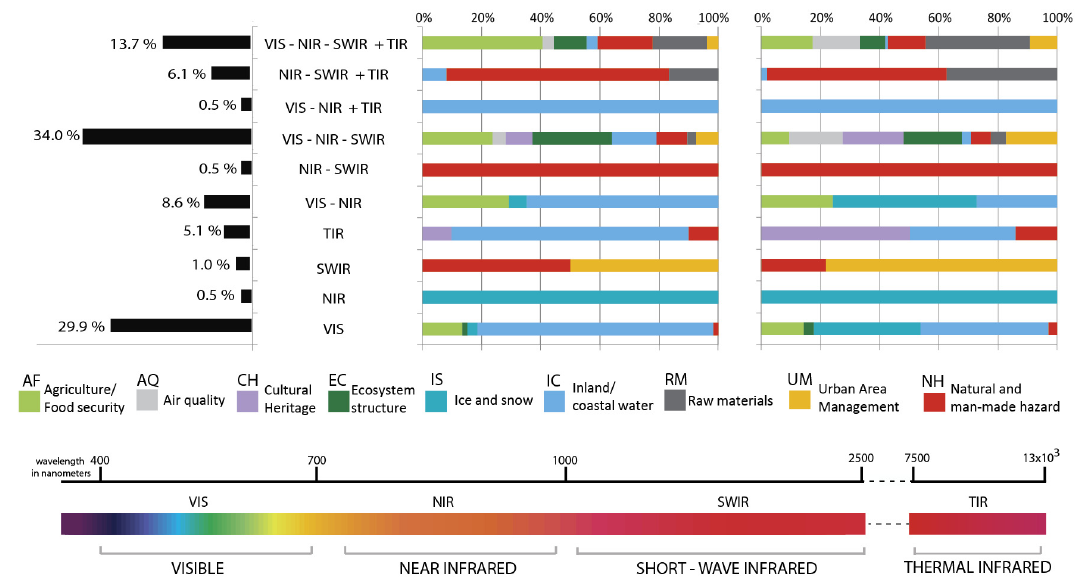
Figure 10. Frequency distribution of spectral range classes. From left to right: frequency distribution of spectral range classes as sum of the preference expressed by all the thematic areas on each class; frequency of the preferences expressed by each thematic area in each class; frequency of preferences expressed by all the thematic areas on each class. The legend of colors and acronyms is located below the frequency distributions.